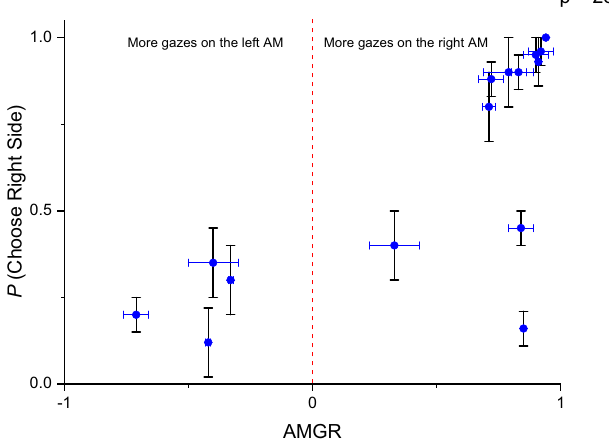
Figure 8. Probability of walking to the right side of the obstacle based on the avoidance margin gaze ratio (AMGR). The dashed line is zero AMGR (gazes on the right and left avoidance margin were equal in time). p value indicates significant level of univariate logistics regression. Black error bars represent SE for Y-Axis and Blue error bars represent SE for X-Axis.